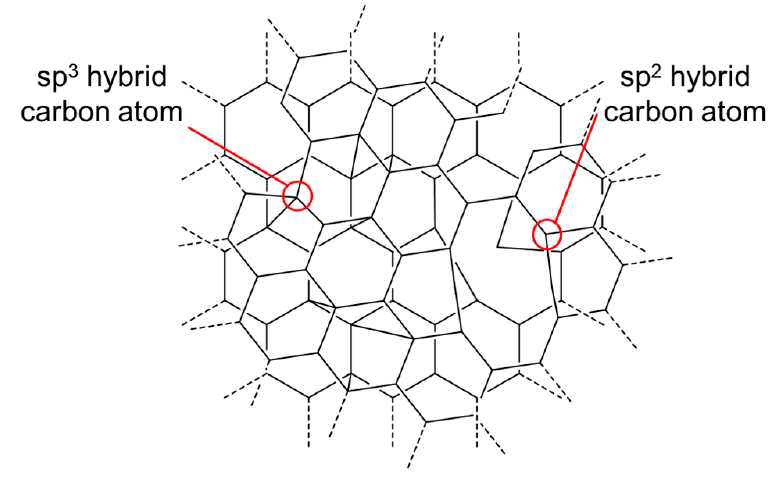
Figure 4. Chemical structure of amorphous carbon.